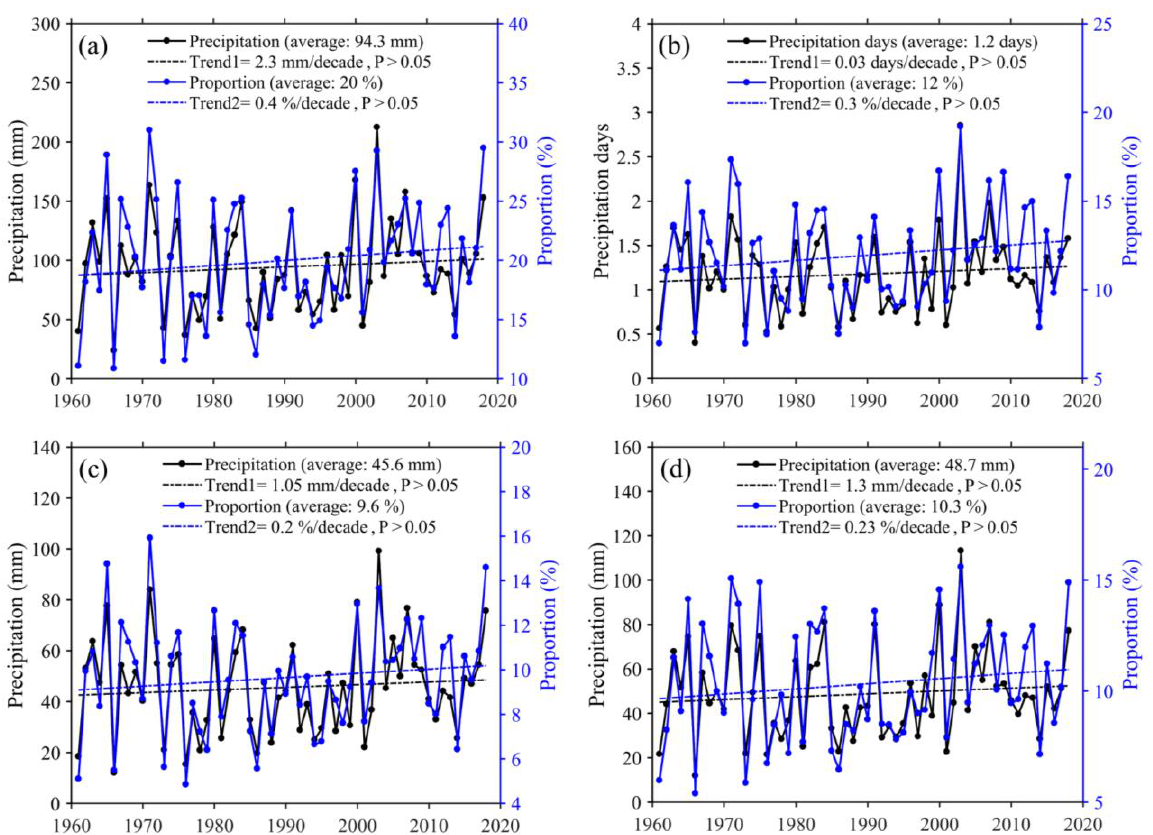
Figure 15. Annual variations in ( a ) CEDNP amount and its proportion to TR90p, ( b ) CEDNP days and its proportion to TR90p days, ( c ) daytime precipitation amount to CEDNP and its proportion to TR90p, and ( d ) nighttime precipitation to CEDNP and its proportion to TR90p.